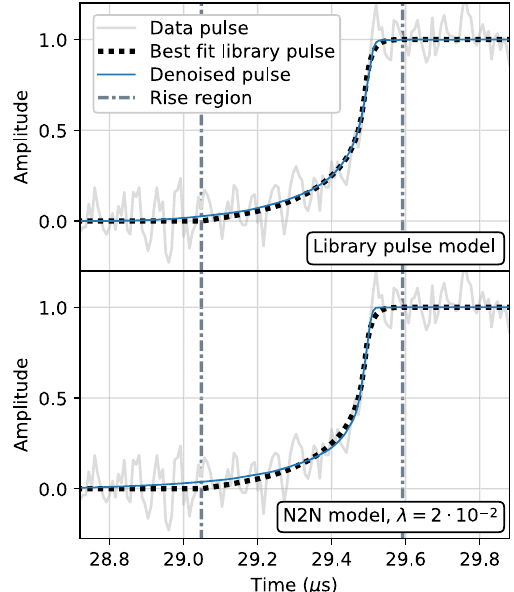
Fig. 9 An example single-site event from the 241 Am dataset. Included in each plot is the noisy data pulse (solid light line), the best fit library pulse (dotted line), and the corresponding denoised pulse (solid dark line) from the regular library pulse model (top) and Noise2Noise model